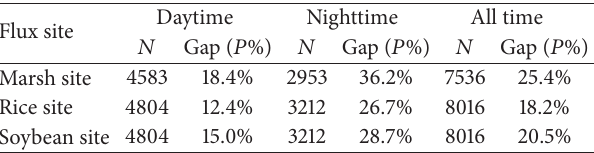
Table 1: Percentages of original gaps in NEE measurements.